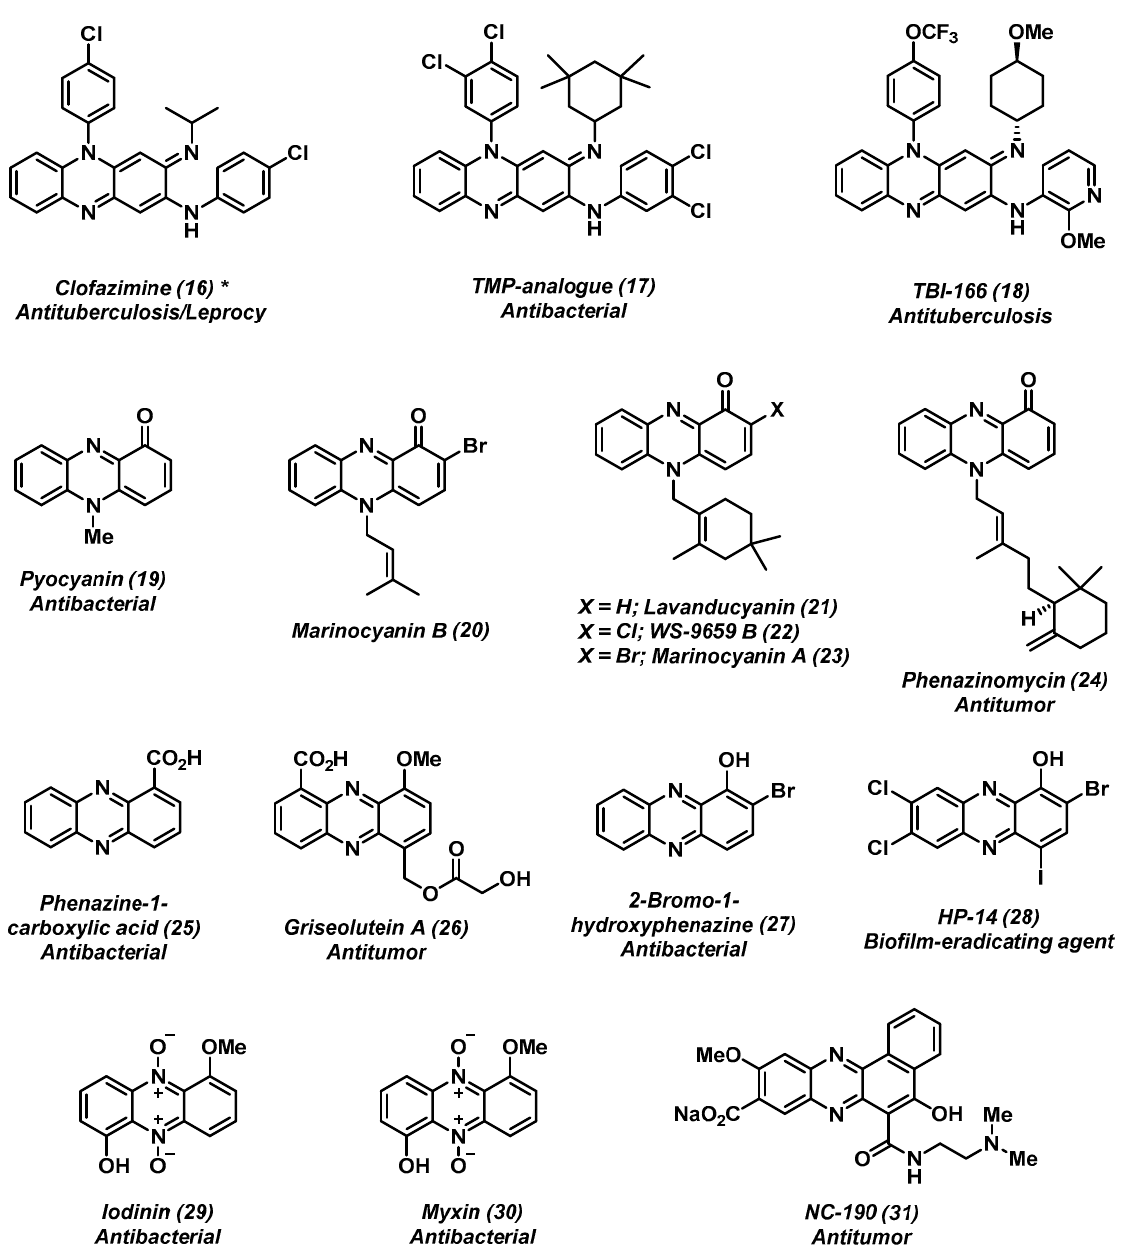
Figure 3. Phenazine heterocycles that demonstrate biological activities, including FDA-approved